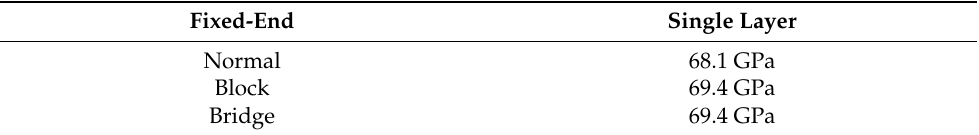
Table 2. Effective Young’s modulus of the as-fabricated Ti/Au micro-cantilevers by FEM simulations.